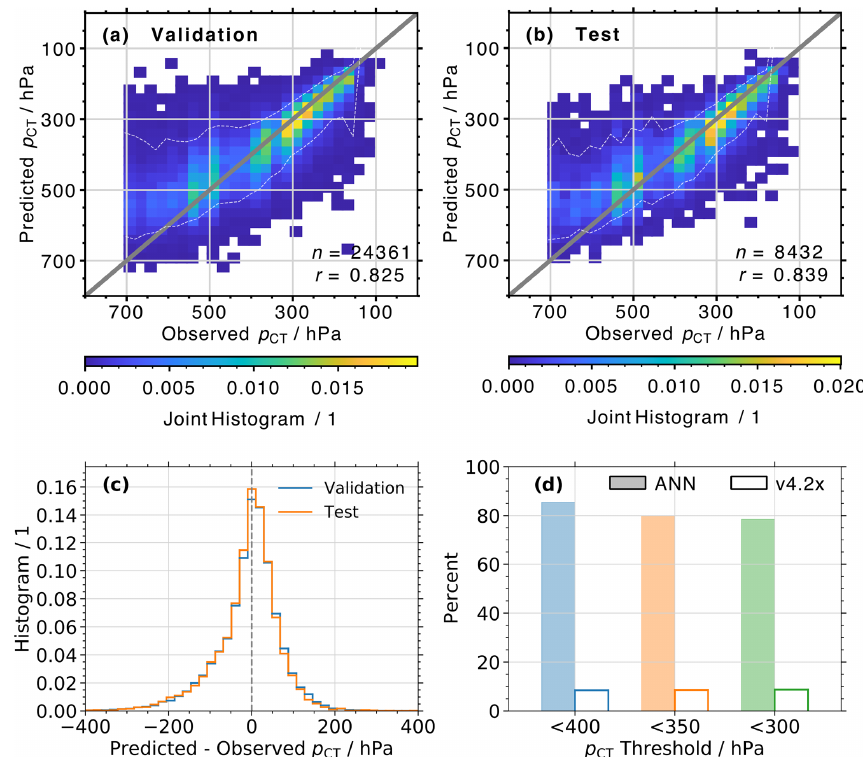
Figure 10. (a) Normalized joint histograms of true and predicted cloud top pressure ( p CT ). Data are from the validation data set. (b) Same as (a) but for the training data set. (c) Histograms of the difference between predicted and observed p CT , for profiles in the validation (blue) and test (orange) data set. (d) Percent of observed p CT < 400, 350, and 300hPa that was successfully detected by the ANN (color-filled bars) and flagged by the v4.2x algorithm (transparent bars). Data are from both the validation and test data